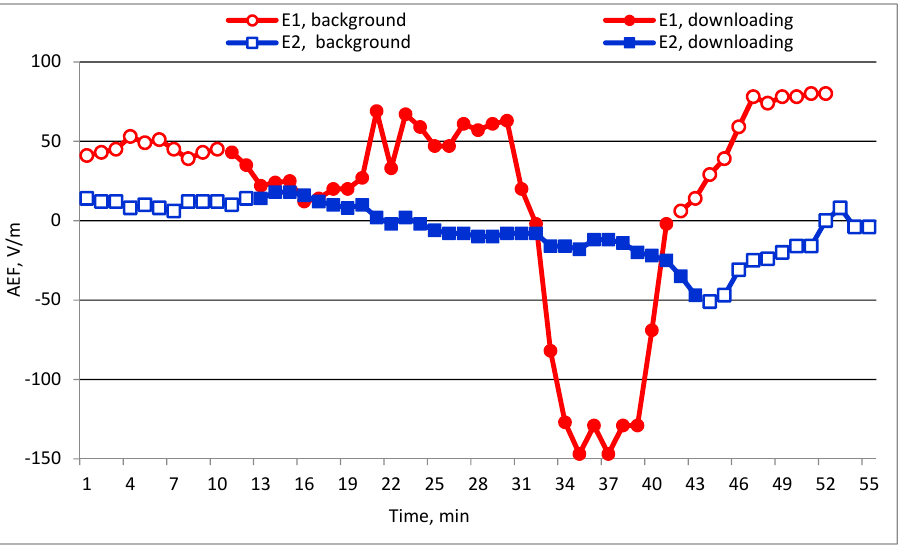
Figure 10. Variations of the atmospheric electric field during 1 and 2 cycles of pumping 30 m 3 of fluid into the ground to a depth of 50